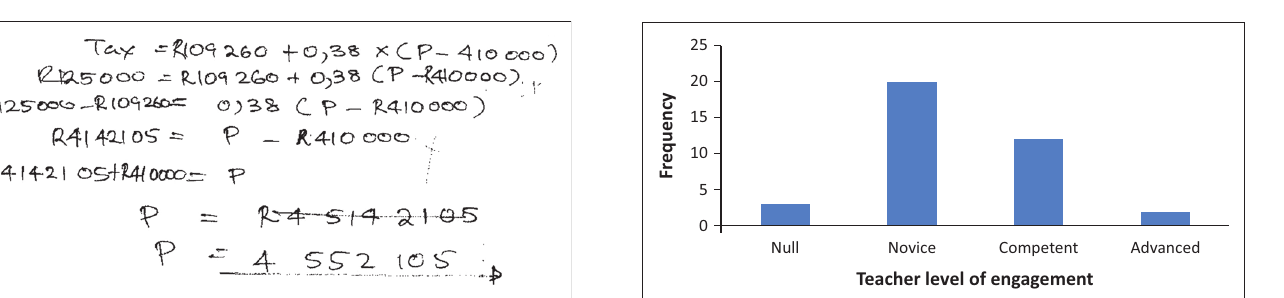
FIGURE 9: Frequency of responses in each